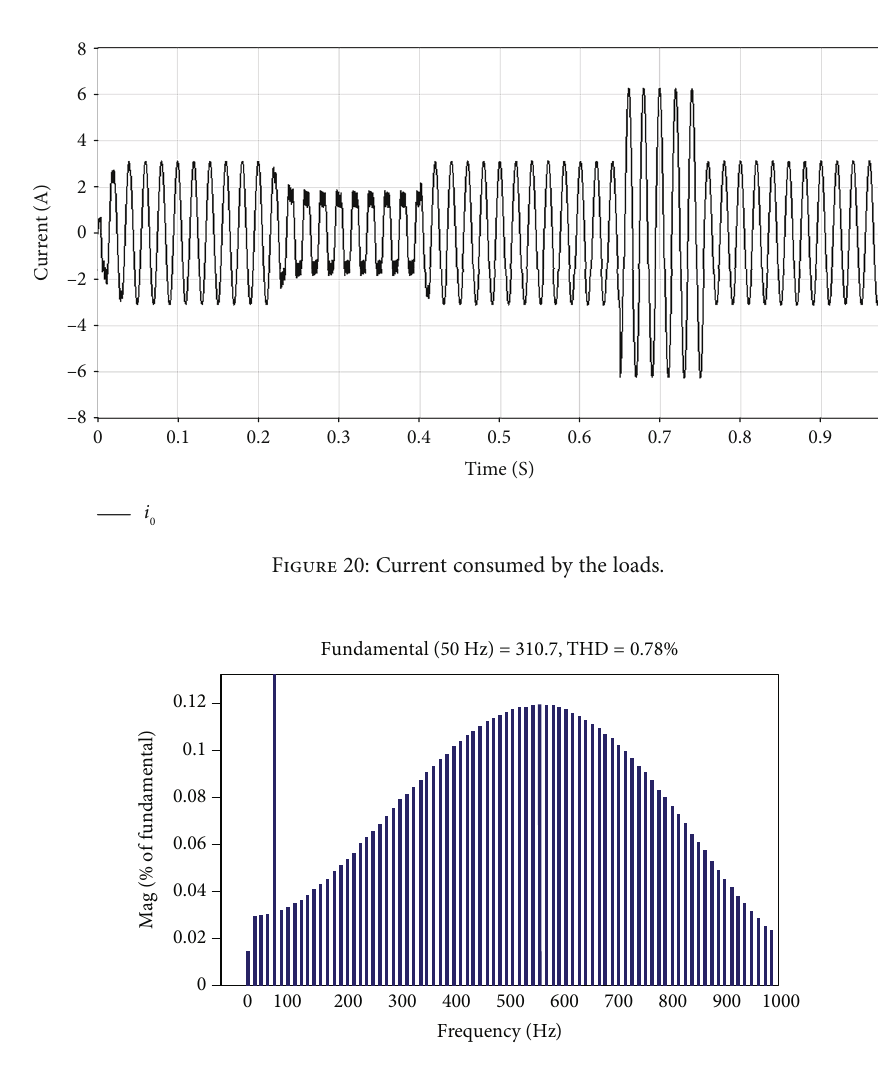
Figure 21: Frequency analysis of the output voltage inverter. Table 3: E ffi ciency of two stages of the whole system under di ff erent solar irradiation